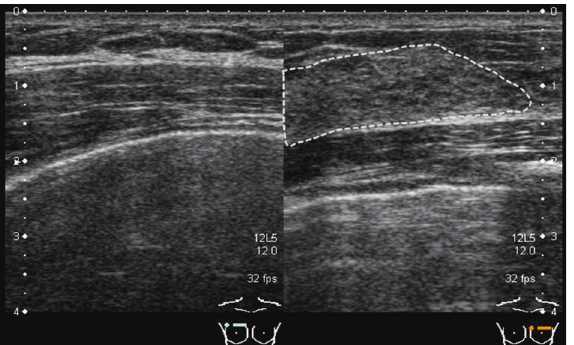
Figure2:Ultrasound:thoraxandpectoralismajoraresymmetric.Areaframedbyabrokenlineisanormalmammaryglandontheunaffected side.